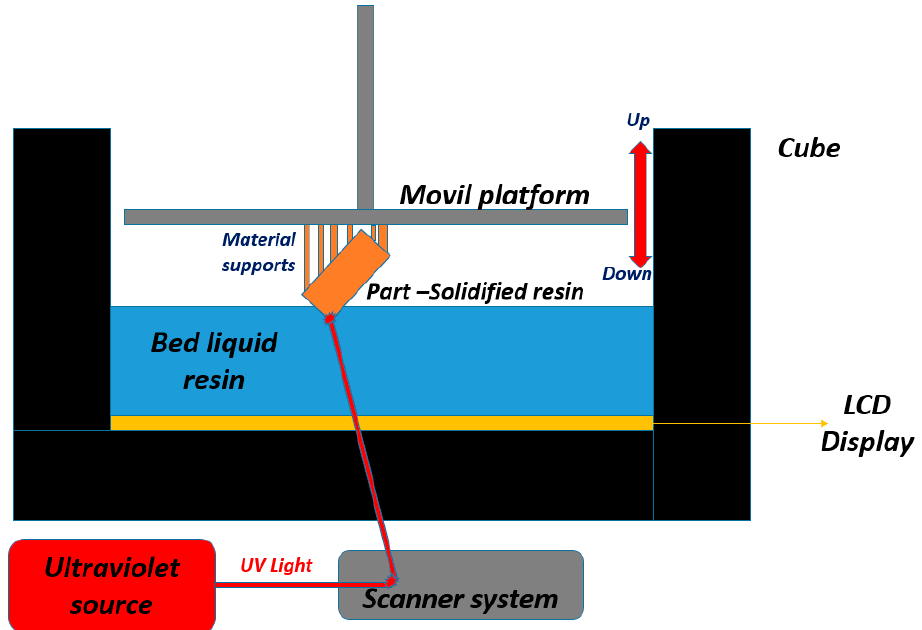
Figure 1. Printing principle of stereolithography (SLA).